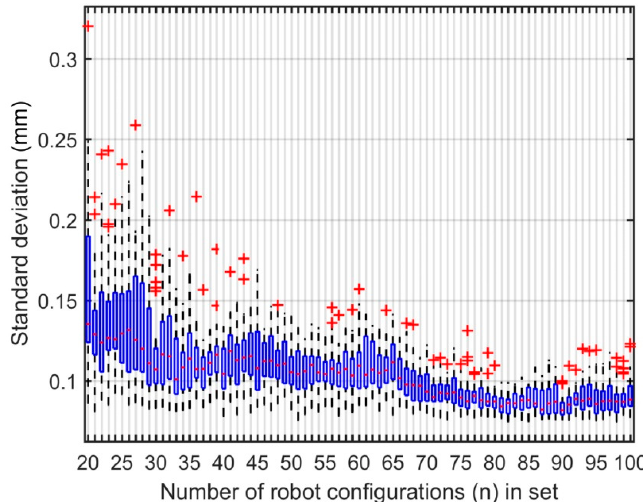
Figure 9. Box and whisker plot, standard deviation of absolute position errors after calibration.